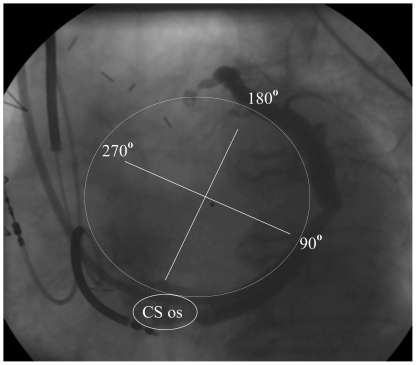
CS lead position is defined by a coordinate system using the projection on the mitral ring in one plane.The grading begins at the CS ostium and reaches 180° at the turnaround point, when the spatial distance to the CS ostium begins to decrease. With this grading system the position of a CS lead can be defined irrespective of the actual morphology of CS branches.